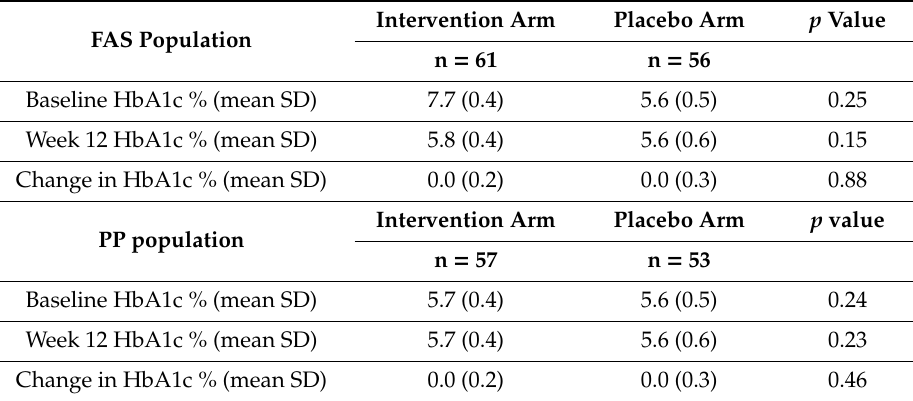
Table 4. Changes in HbA1c (FAS population).